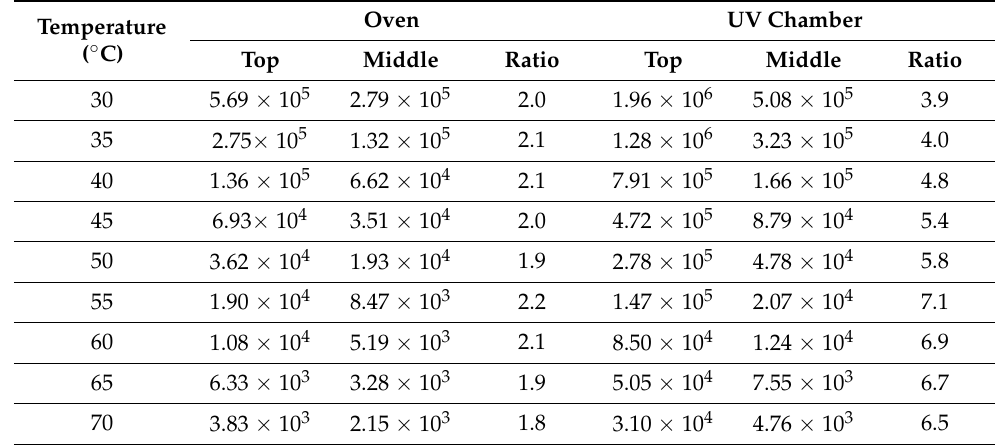
Figure 4. Complex modulus at 1 Hz reference frequency and mid-range temperatures. Table 5. Average complex shear modulus (Pa) at 1 Hz reference frequency.